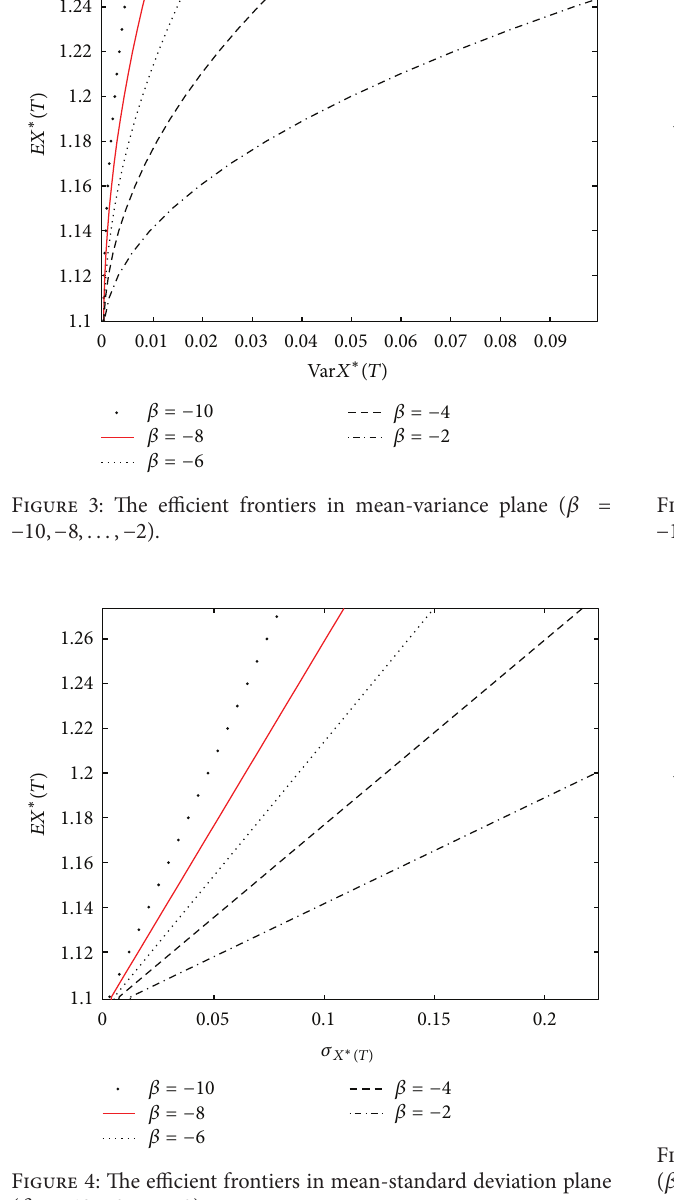
Figure 4: The efficient frontiers in mean-standard deviation plane ( 𝛽 = −10, −8,...,−2 ).